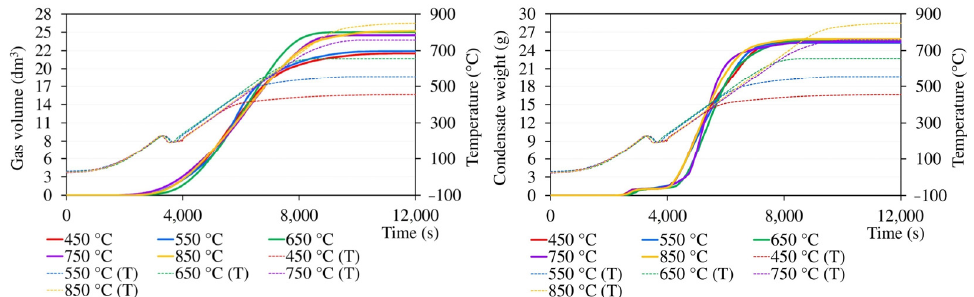
Figure A3. The course of the release of the gas and total condensates during pyrolysis (T indicates temperature inside the sample layer).